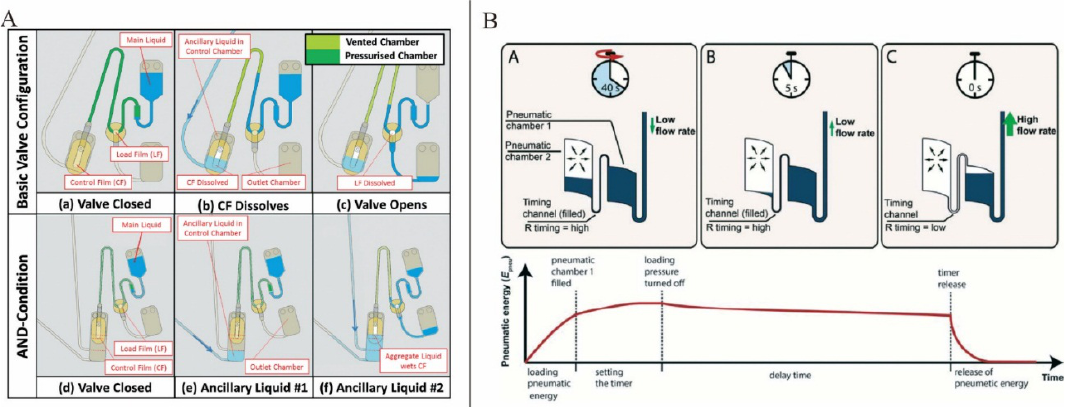
Figure 4. ( A ) Basic event triggered valve and AND-condition valve. Figure reprinted with permission from [56]. ( B ) Microfluidic timer. Figure reprinted with permission from [58].